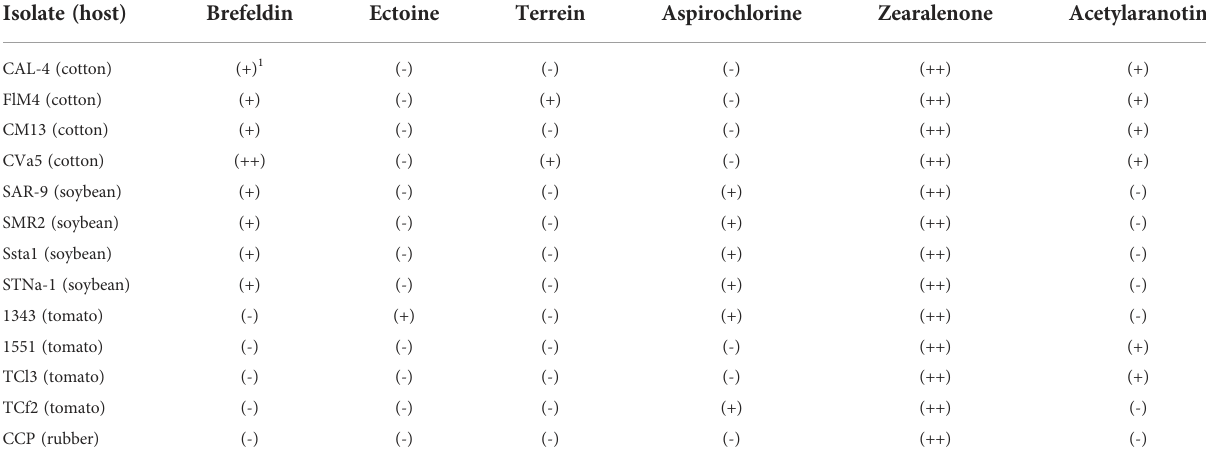
TABLE 3 Gene clusters identi fi ed in the Corynespora cassiicola genomes containing genes with similarity to toxin gene clusters. Isolate (host) Brefeldin Ectoine Terrein Aspirochlorine Zearalenone